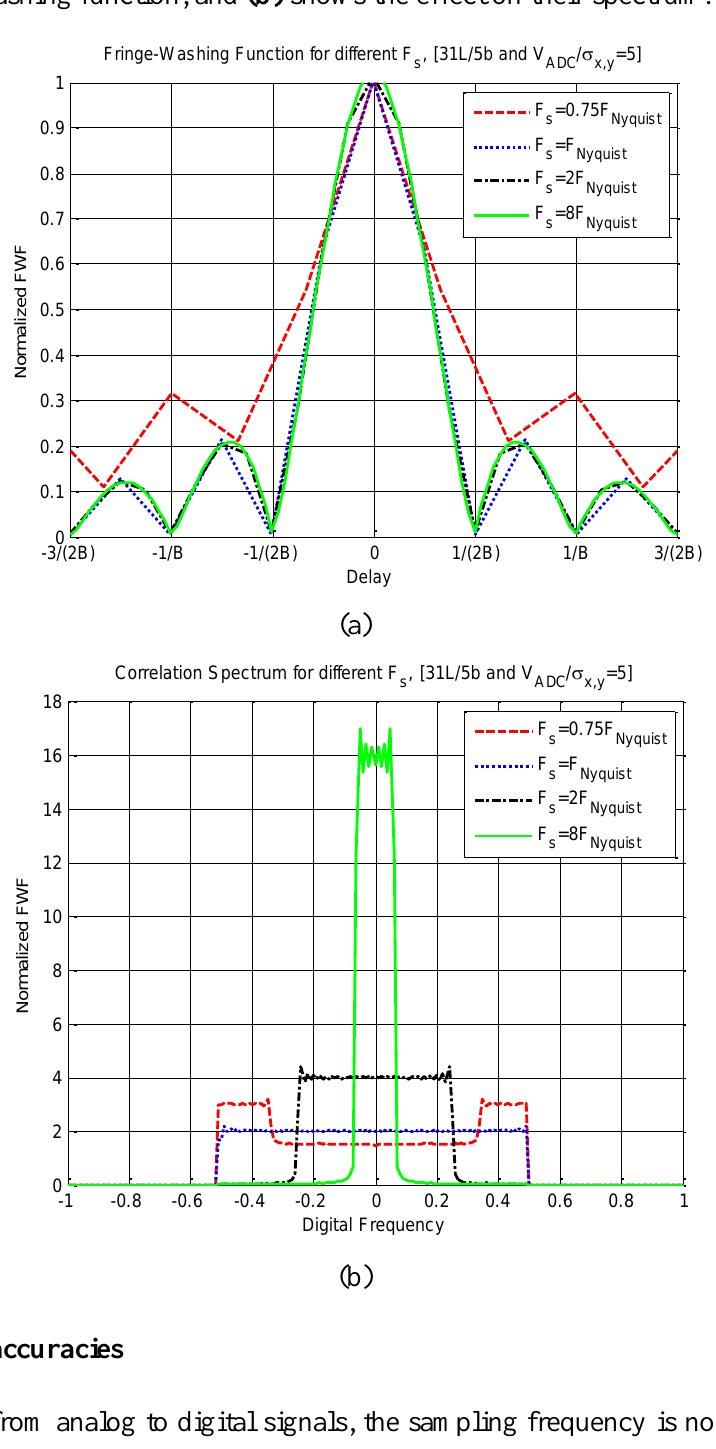
= 5 σ . (a) shows the deformation ADC x,y